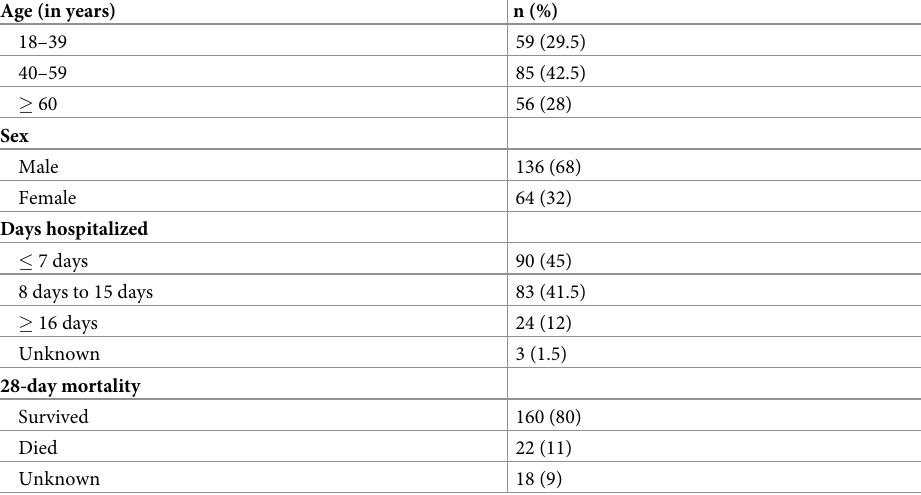
Table 2. Summary of study participants. Age, sex, days in the hospital and clinical outcome are summarized. The number (n) for each group is given with the percentage of that group in parentheses. Age (in years) anorexia (n = 153/200, 76.5%), shortness of breath (n = 142/200, 71%), excessive sweating (n = 136/200, 68%), shaking/rigors (n = 133/200, 66.5%), headache (n = 132/200, 66%), cough (n = 123/200, 61.5%), and abdominal pain (n = 110/200, 55%) (S2 Table). Of the 174 patients who consented to an HIV test, 12/174 (6.9%) were positive. Out of 200 patients, 93 patients (46.5%) received at least one microbiological diagnosis after